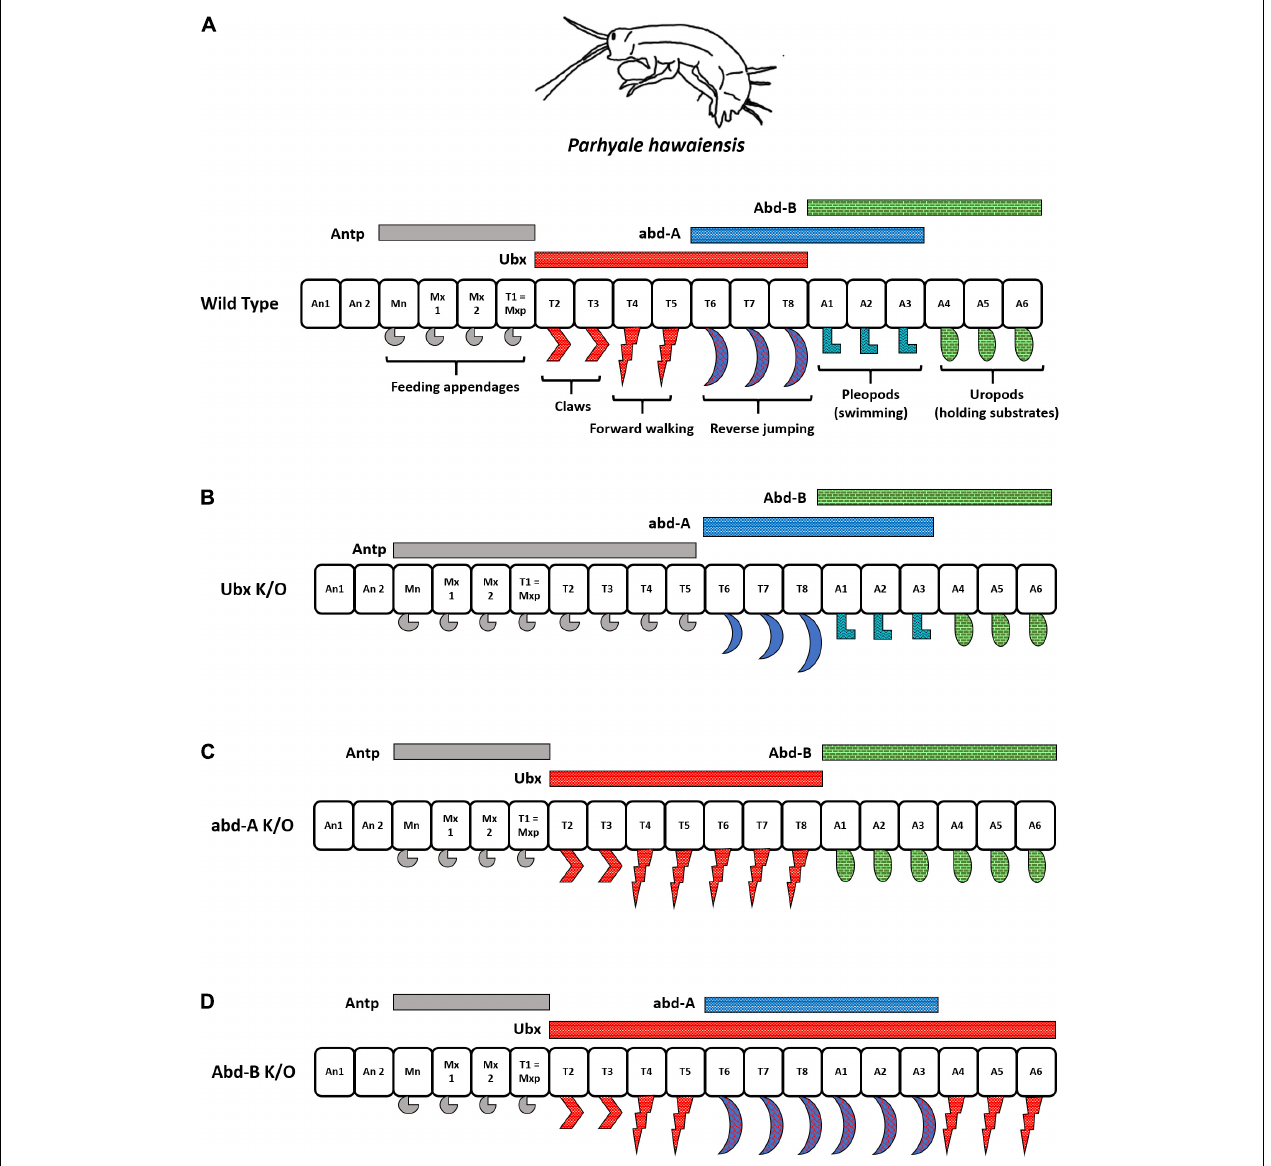
FIGURE 6 | Interplay of different Hox genes in Parahyale hawaiensis . (A) Hox expression in Parhyale hawaiensis . Note that abd-A has overlapping regions of functioning with Ubx as well as Abd-B . (B) Ubx knock-out animals show anteriorization of forward walking legs. (C) abd-A knock-out animals show anteriorization of reverse walking legs and posteriorization of swimming appendages. (D) Abd-B knock-out animals show anteriorization of swimming appendages into reverse walking legs and uropods in forward walking